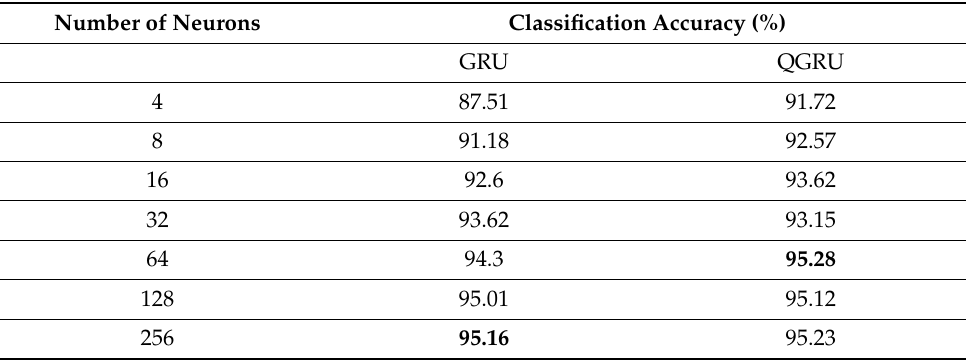
Table 4. Comparison between the QGRU and GRU performance on the HAR task.